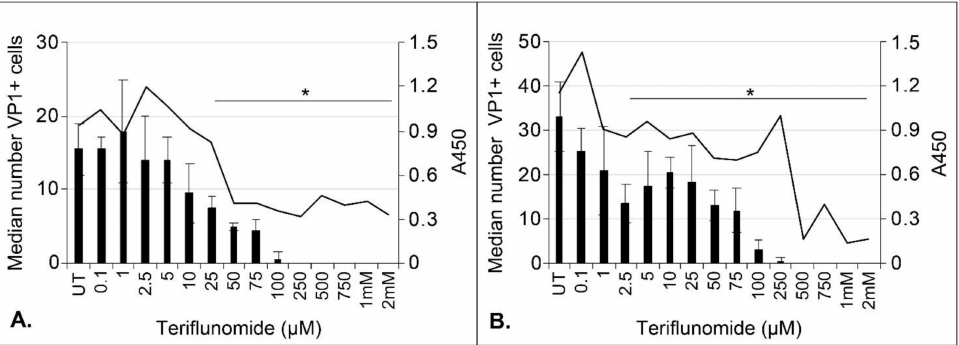
Figure 2. The ability of teriflunomide to reduce JCPyV infection correlates with teriflunomide’s cytostatic effect in CPEpic-L and primary astrocytes. CPEpic-L ( A ) and primary astrocytes ( B ) were pretreated with teriflunomide for 1 h, infected, and maintained in the presence of teriflunomide for 5 days. Cells were fixed in 100% methanol and analyzed by indirect immunofluorescence analysis of VP1. The median number of VP1-positive cells (left axis) is plotted against the A450 (right axis) to show the relationship between decreased infection and the cytostatic effect of teriflunomide. Error bars indicate the IQR of each sample. There is a significant reduction in infection in CPEpic-L cells at 25 µ M and above and in astrocytes at 2.5 µ M and above. * = p < 0.05, Student’s t -test; UT = untreated; VP1 = viral protein 1; IQR = interquartile range.